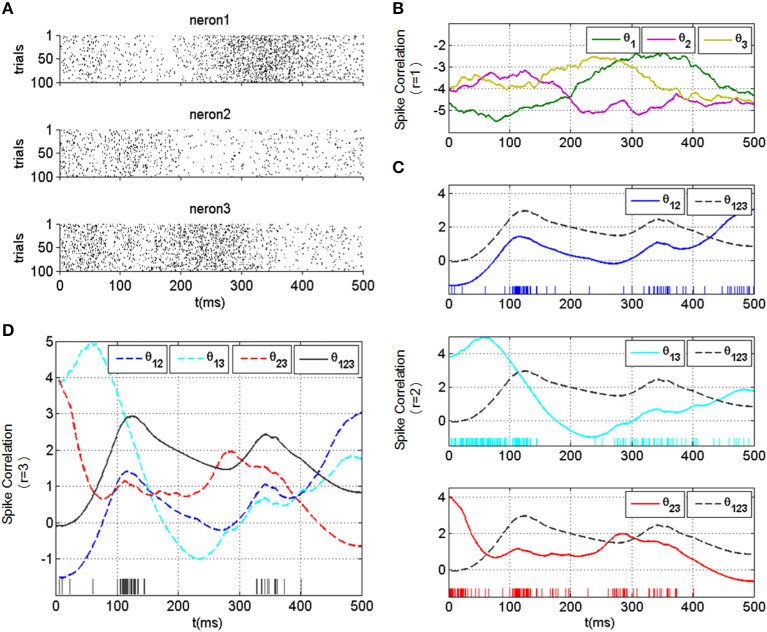
Estimation of spike correlations for simulation data of three neurons. (A) Simulated ensemble spike activities. The number of neurons is N = 3 and the number of trials is n = 100. (B) First-order spike correlations: θ1, θ2, and θ3 (green, pink, and yellow solid lines). (C) Second-order spike correlations: θ12, θ13, and θ23 (blue, cyan, and red solid lines). (D) The third-order spike correlation: θ123 (gray solid line). Raster with different colors at the bottom show the timing of corresponding order synchronous spikes.